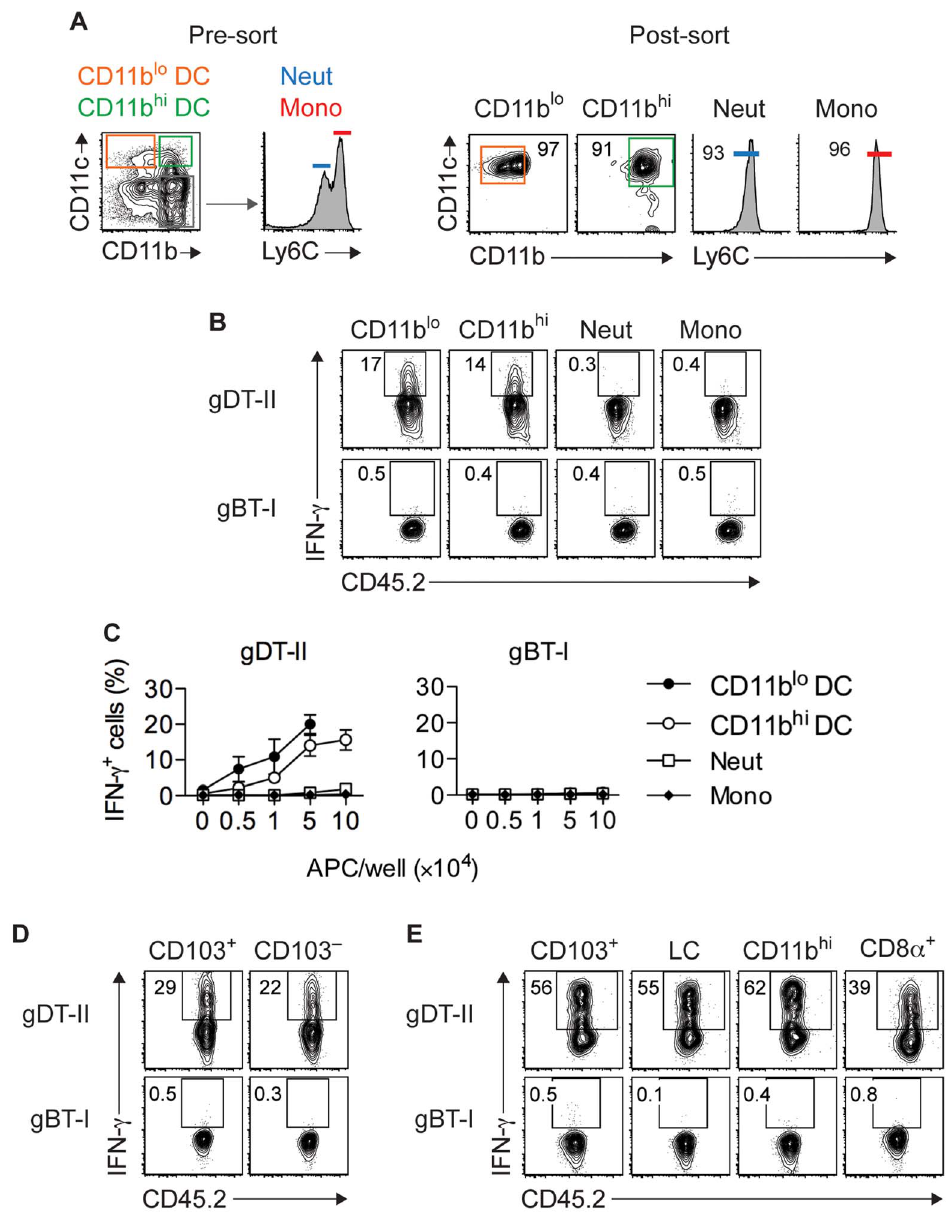
Figure 5. Multiple DC subsets elicit IFN- c production by CD4 + but not CD8 + T EFF cells. ( A ) Sorting strategy used to isolate CD11c + CD11b lo and CD11c + CD11b hi DCs, CD11c 2 Ly6C int neutrophils (Neut) and CD11c 2 Ly6C hi monocytes (Mono) from skin 5 days after HSV-1 infection. ( B , C ) Analysis of IFN- c + cells after culture of in vitro activated gDT-II and gBT-II effector cells with 5 6 10 4 ( B ) or increasing numbers ( C ) of sorted APCs pooled from 10–20 mice. Culture period, 5 h for gBT-I and 18 h for gDT-II cells. Data pooled from 2–3 experiments. ( D , E ) Analysis of IFN- c + T EFF cells cultured with indicated DC subsets pooled from 10–20 mice and sorted from skin ( D ; 1.5 6 10 4 ) or axillary LNs ( E ; 5 6 10 4 ) 5 days after infection as in B , C . LC, Langerhans cells. Representative plots from 2–3 independent